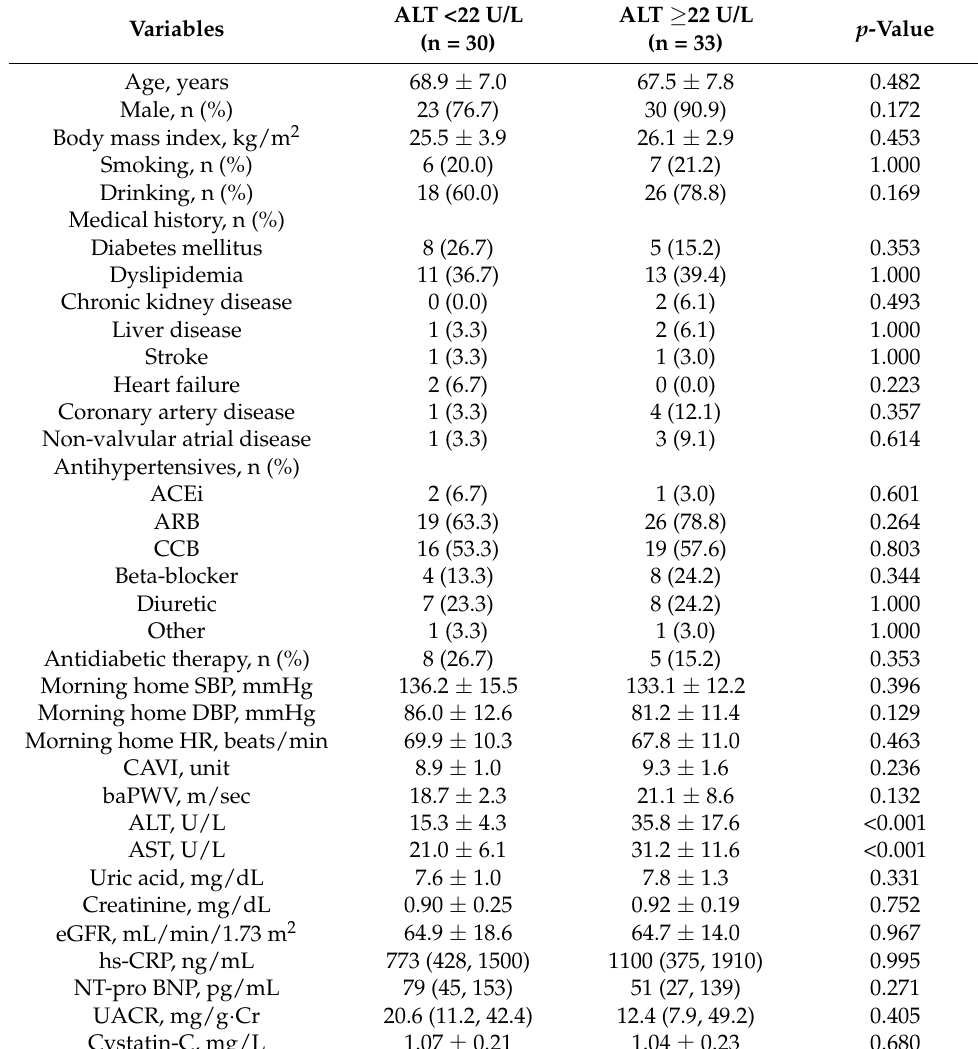
(Table 2), or above or below 40 U/L (the upper limit of normal) (Table 3) (Figure S1). Table 1. Baseline clinical characteristics of participants with alanine aminotransferase level <22 U/L or ≥ 22